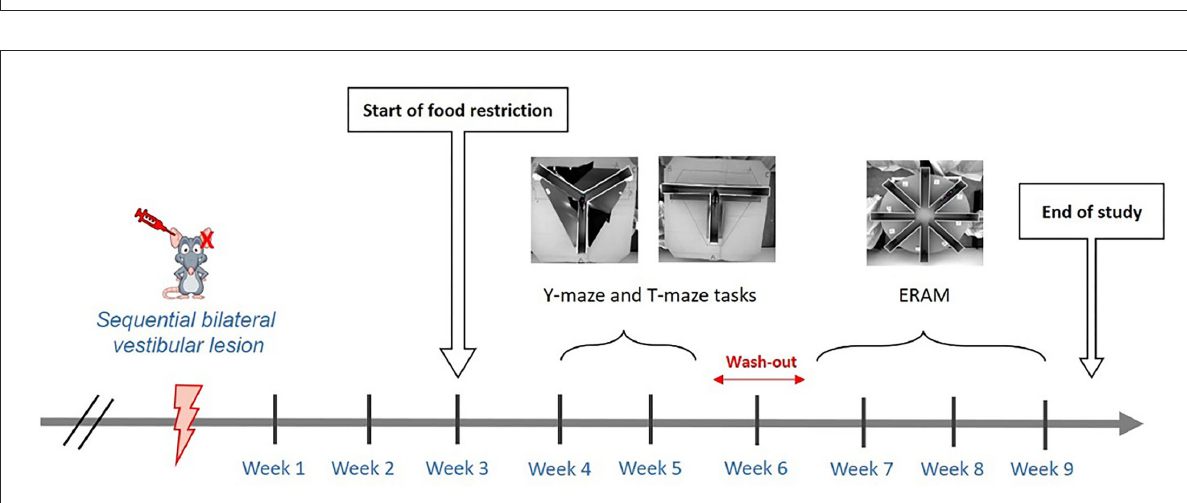
FIGURE2 Timeline of the spatial cognition assessment. Assessment of spatial cognition was performed through three sequential behavioral tests: Y-maze, T-maze, and ERAM. Y-maze and T-maze started 4 weeks after sequential bilateral transtympanic injection, whereas ERAM started seven weeks after sequential bilateral transtympanic